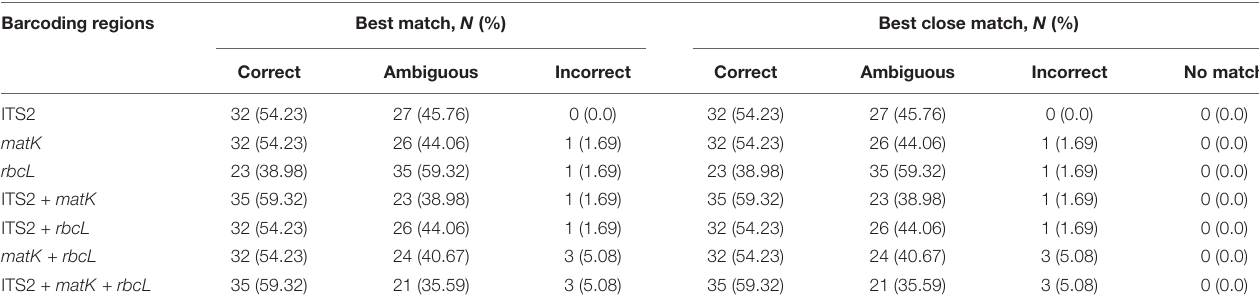
TABLE 5 | Number (rates) of sample identification based on the analysis of the “best match” and “best close match” functions using TAXONDNA software for each DNA barcoding marker and combinations from 59 individuals. Barcoding regions Best match, N (%) Best close match, N (%)